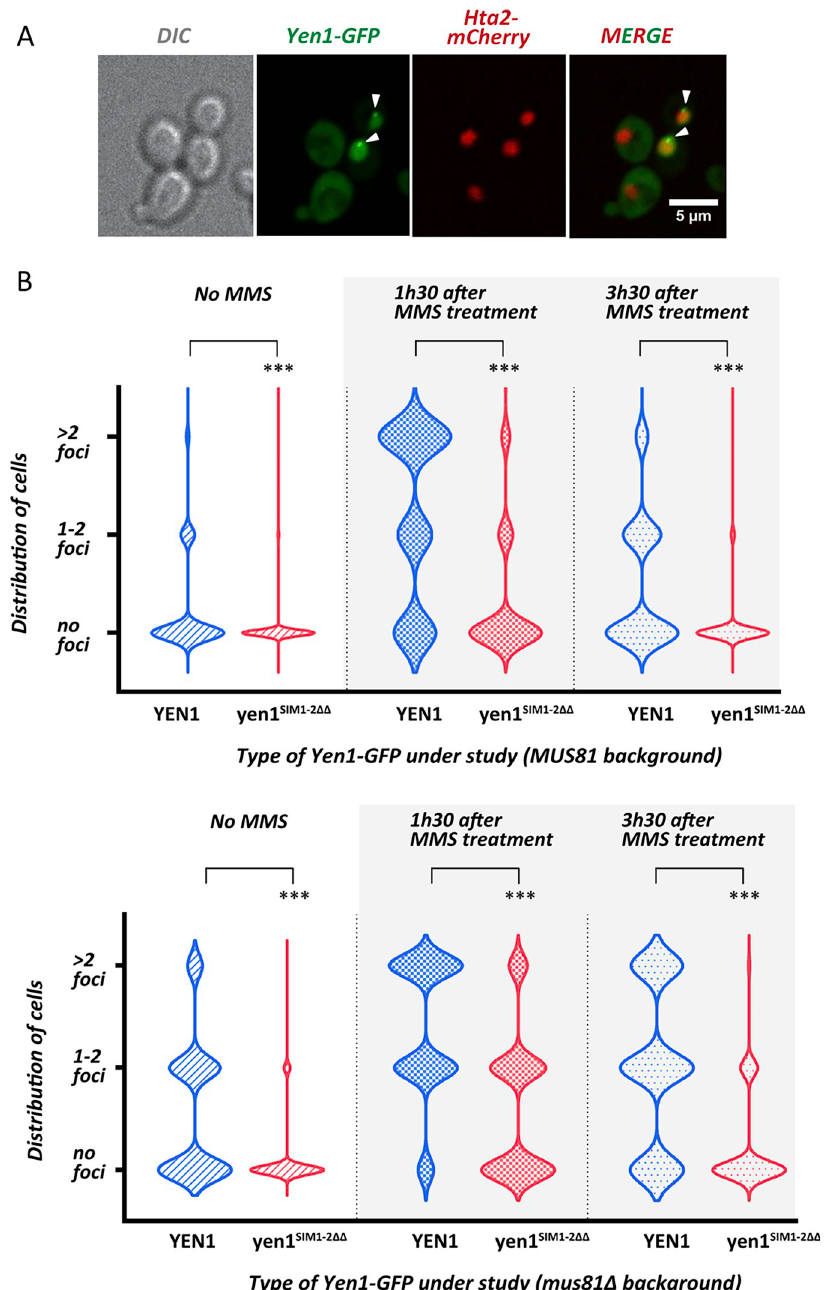
Fig 4. Mutation in the SIMs of Yen1 prevents foci accumulation in G2/M. (A) Cells with an endogenous copy of Hta2-mCherry and YEN1-HA expressing Yen1-GFP from an inducible vector were observed under a spinning-disk microscope after a brief induction with galactose. The white triangles denote the presence of Yen1-GFP foci. (B) Chromosomally tagged Yen1-HA wild-type and SIM mutant in the indicated genetic backgrounds and carrying its corresponding Yen1-GFP expressing plasmid (blue graphs for WT copy, red for SIM mutant) were observed under the microscope after a brief induction. Cells from the indicated conditions were classified according to its cell cycle phase and the presence or absence of Yen1 foci. Violin Plots display the distribution of G2/M cells showing no foci, 1–2 foci or more than 2 foci for each strain. Counting was performed for over 400 distinct G2/M cells for each strain over several independent trials. Asterisks represent statistical significance in a χ 2 test p < 0.0001 ( ��� ), see S4 and S5 Tables for details.